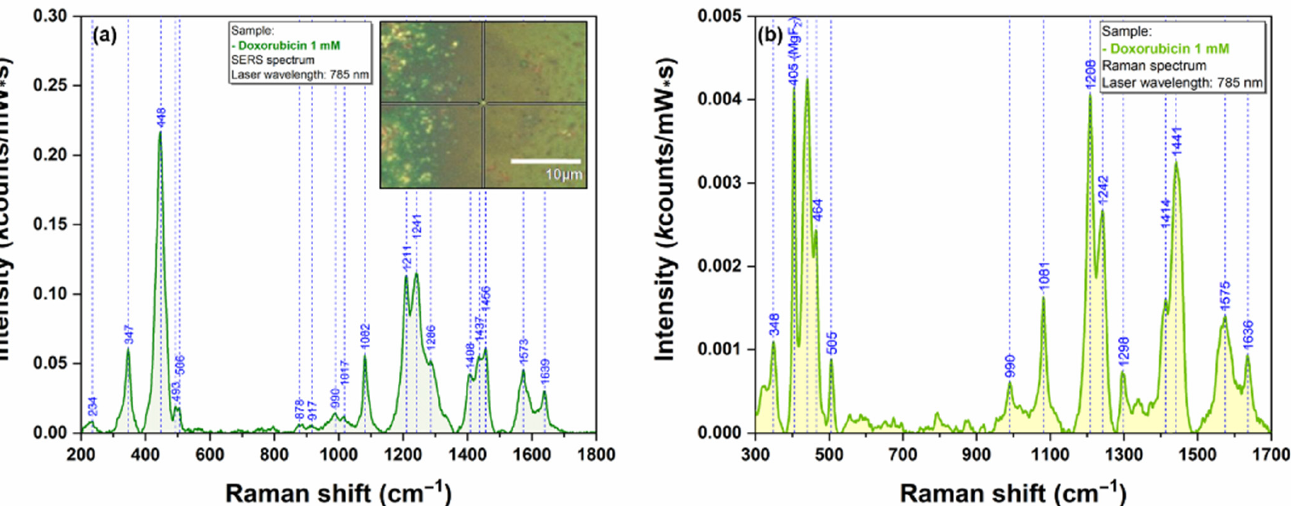
Figure 8. SERS spectrum of dried DOX solution (1 mM) collected on an isolated nanostar using a 785 nm excitation laser ( a ). The inset shows an optical image of the individual nanostar that has been used as plasmonic substrate. Raman spectrum of dried DOX solution (1 mM) collected using a 785 nm excitation laser ( b ).